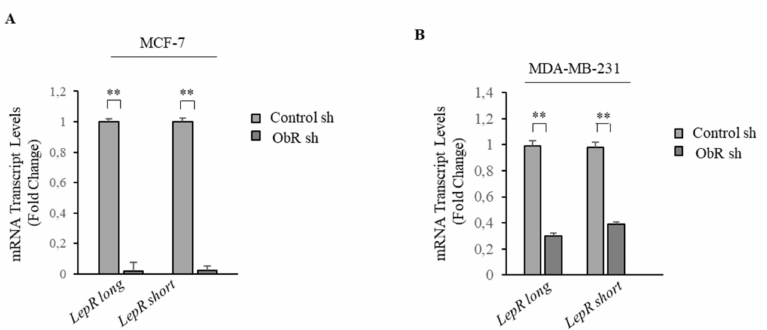
Figure 1. Expression of leptin receptor in ObR sh MCF-7 and MDA-MB-231 breast cancer cells. Real time RT-PCR assay for leptin receptor (long and short isoforms) mRNA expression in control sh and ObR sh MCF-7 ( A ) and MDA-MB-231 ( B ) breast cancer cells. The values represent the mean ± SD of three di ff erent experiments, each performed in triplicate. ** p <